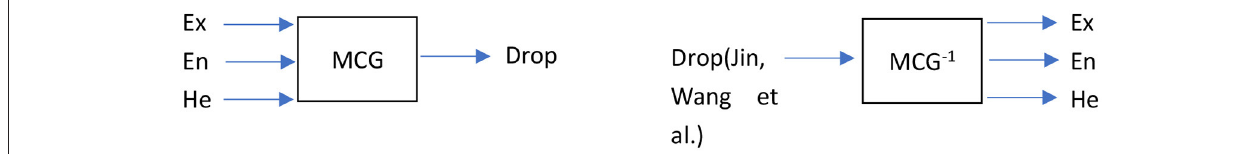
FIGURE 1 | Forward and backward membership cloud generator (MCG &MCG − 1 ).